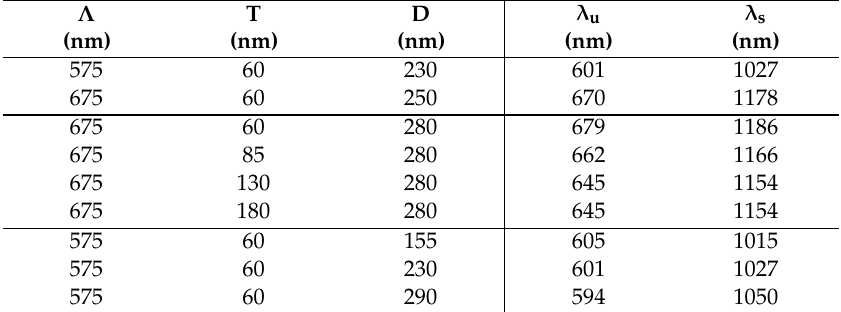
Figure 4. Transmission spectra (in air) of different samples with period of 675 nm, diameter of 280 nm and Au film thickness of 60 nm (black), 85 nm (red), 130 nm (green), and 180 nm (blue).